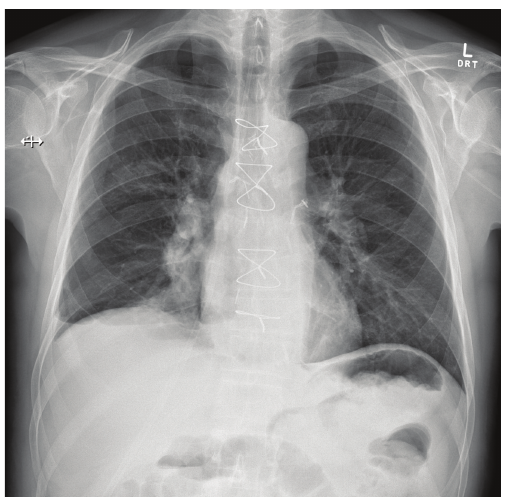
Figure 2: Postbronchoscopy chest